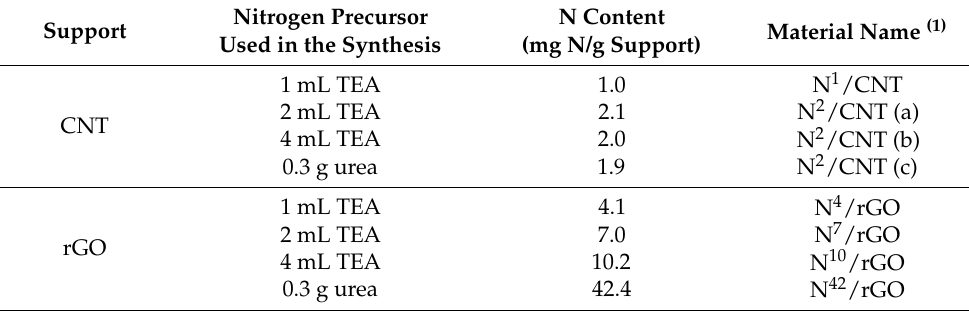
Table 1. N content of the different N-doped